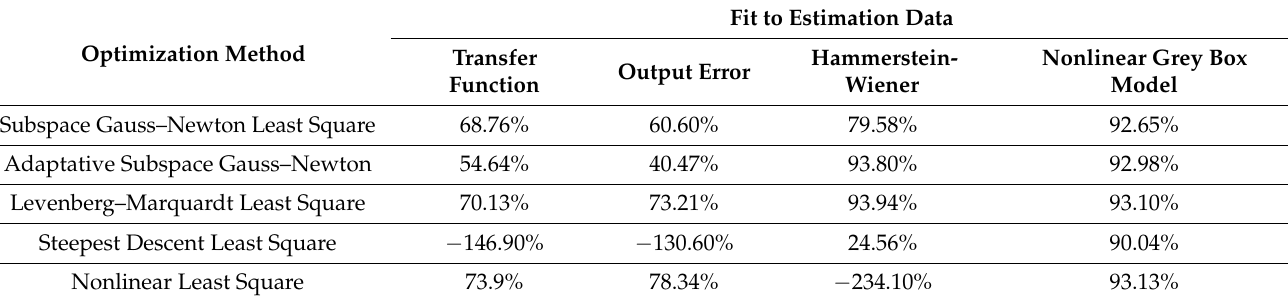
Table 4. Fit to estimation data with all optimization’s methods in each